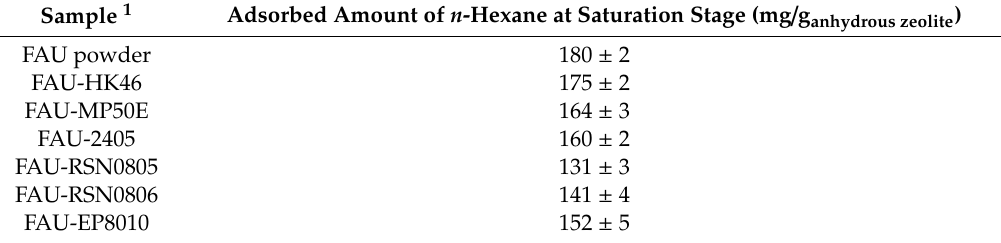
Table 5. Adsorption capacities of n -hexane by pure 13X zeolite and zeolite coatings. Sample